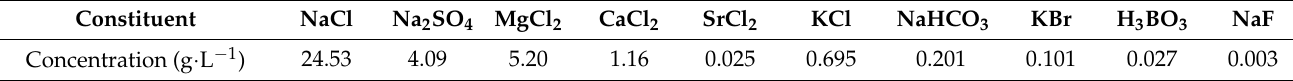
Table 2. Chemical composition of artificial